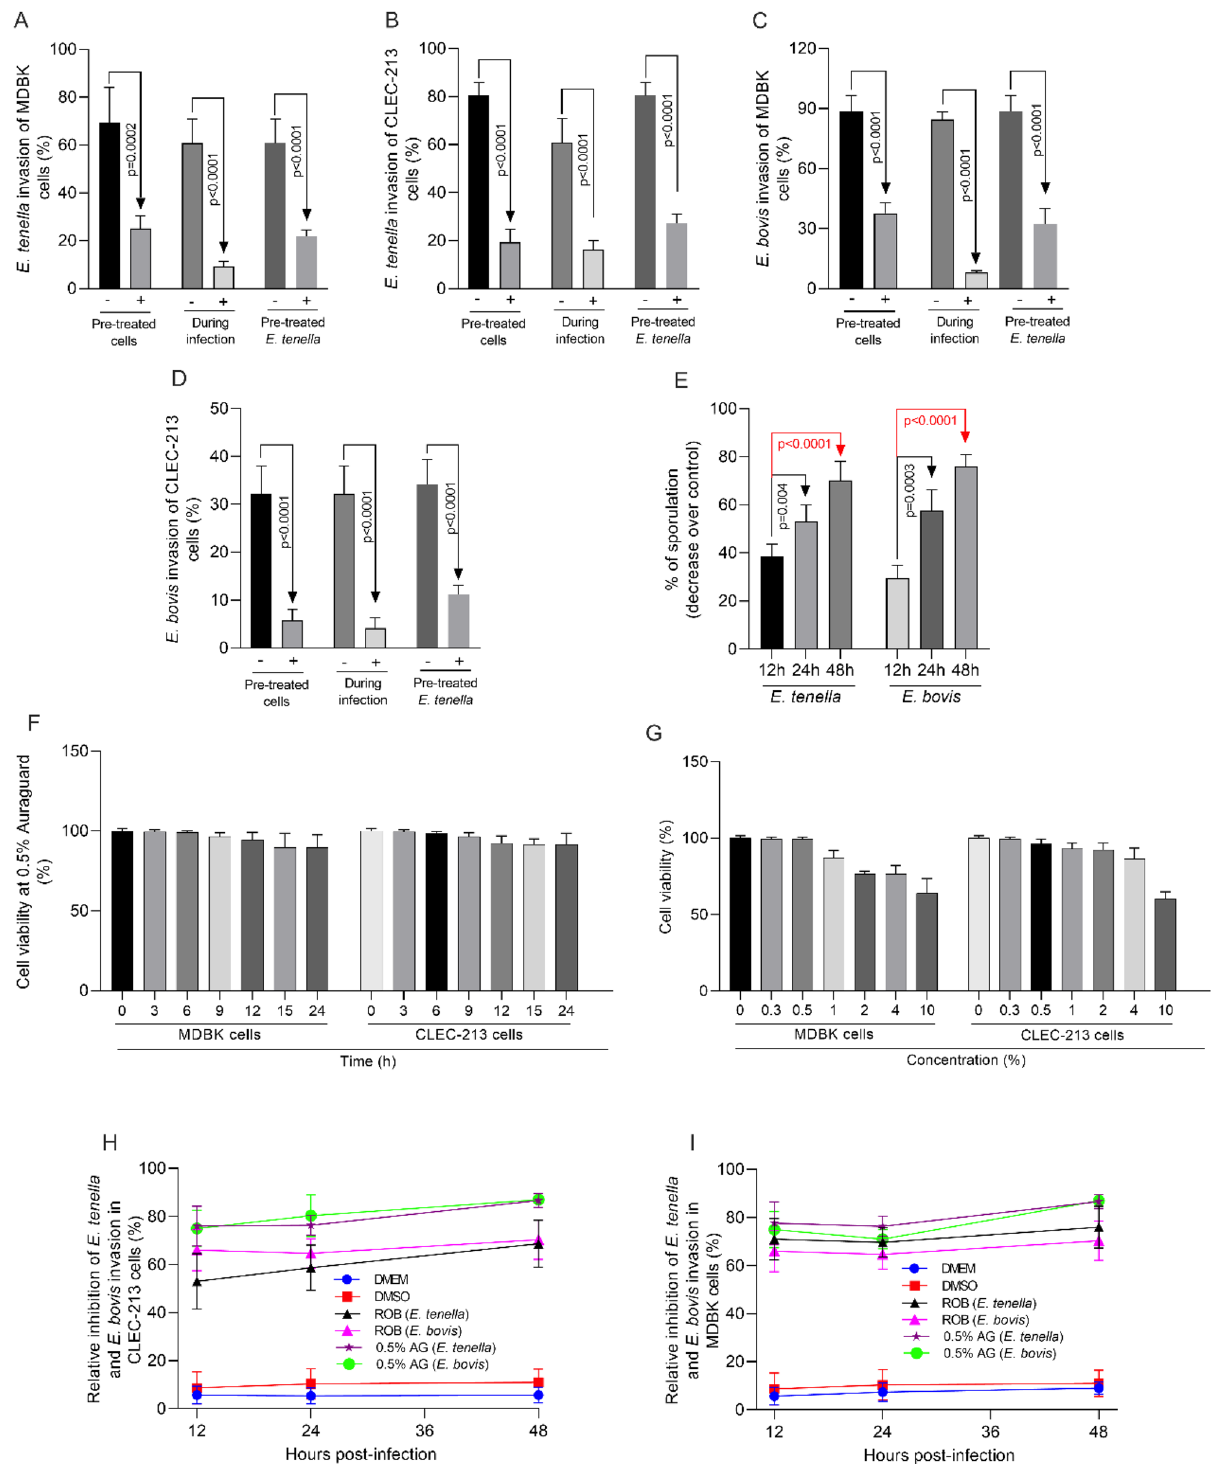
Figure 1. Effect of a mixture of natural antimicrobials (AG) on in vitro cell invasiveness by E. tenella and E. bovis using MDBK, and CLEC cells. ( A ) The effect of AG on the percentual invasion efficiency for E. tenella in MDBK cells and ( B ) for invasion of CLEC-213; ( C ) describes the effect of AG on the invasion of E. bovis in MDBK cells and ( D ) in CLEC-213 cells; ( E ) the in vitro effect of the antimicrobial mixture (AG) on E. tenella and E. bovis oocyst sporulation. ( F ) Describes the in vitro effect of 0.5% AG on cell viability over 24 h and in ( G ) cells were treated with a series of concentrations of AG (0; 0.3; 0.5; 1; 2; 4 and 10%) for 24 h estimated by the MTT assay and expressed as a percentage based on the untreated control cells. Values are the mean ± SE ( n = 6). ( H ) The impact of the antimicrobial mixture (AG) (0.5%) on sporozoite counts by comparison with the anticoccidial robenidine (ROB) (5 μg/ml) in CLEC-213 and Panel I in MDBK cells. The experiments were done in triplicate and in three separate